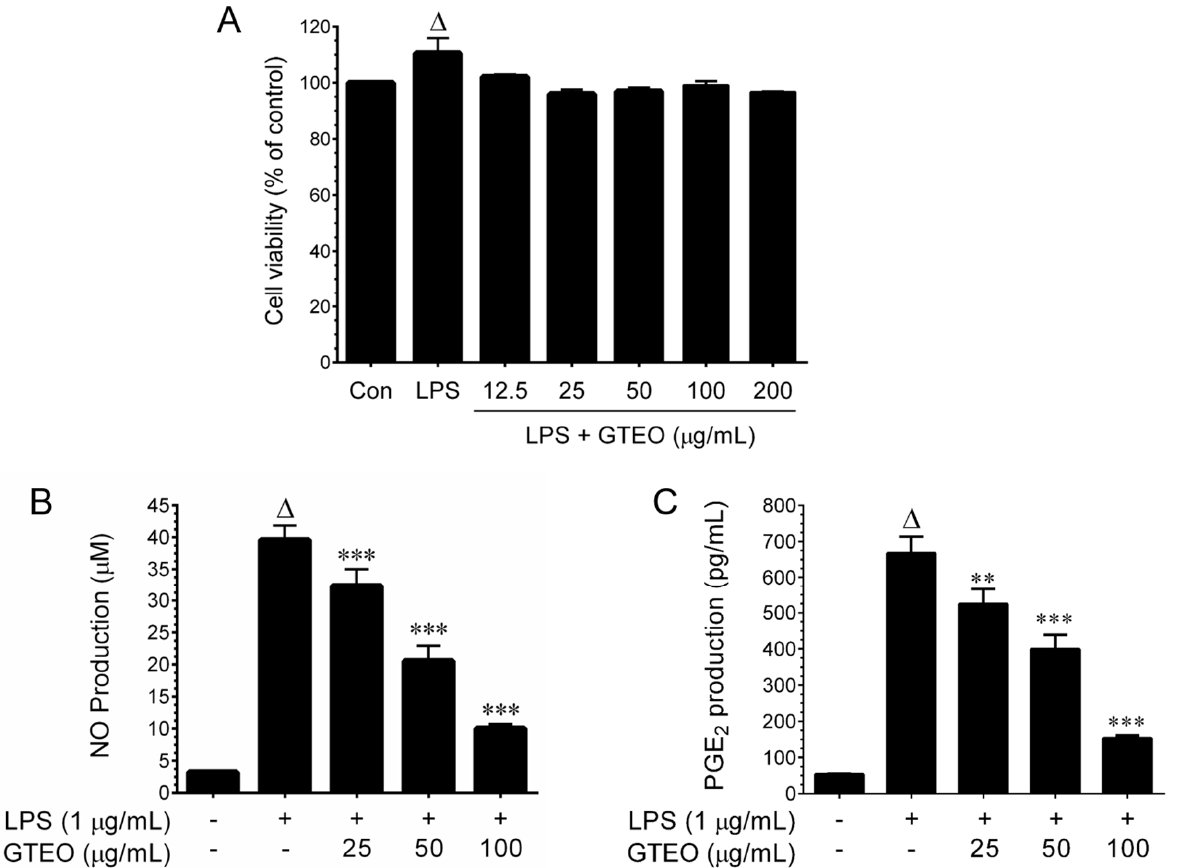
Figure 1. Effect of GTEO on cell viability and LPS-induced NO and PGE 2 production. ( A ) RAW 264.7 cells were stimulated with LPS (1 μ g/mL) and incubated in the presence or absence of increasing concentrations (25–200 μ g/mL) of GTEO for 24 h. The cell viability was determined by the MTT colorimetric assay. ( B ) The nitrite concentration in the culture media was determined by the Griess reagent assay. ( C ) PGE 2 levels in the culture media were measured by a commercially available assay kit as described in materials and methods. Data are reported as mean ± SD of three independent experiments. ∆ p < 0.001 indicates a significant difference between the control and LPS-only treated groups. ** p < 0.01, and *** p < 0.001 show significant differences between the LPS-alone and GTEO treatment groups.